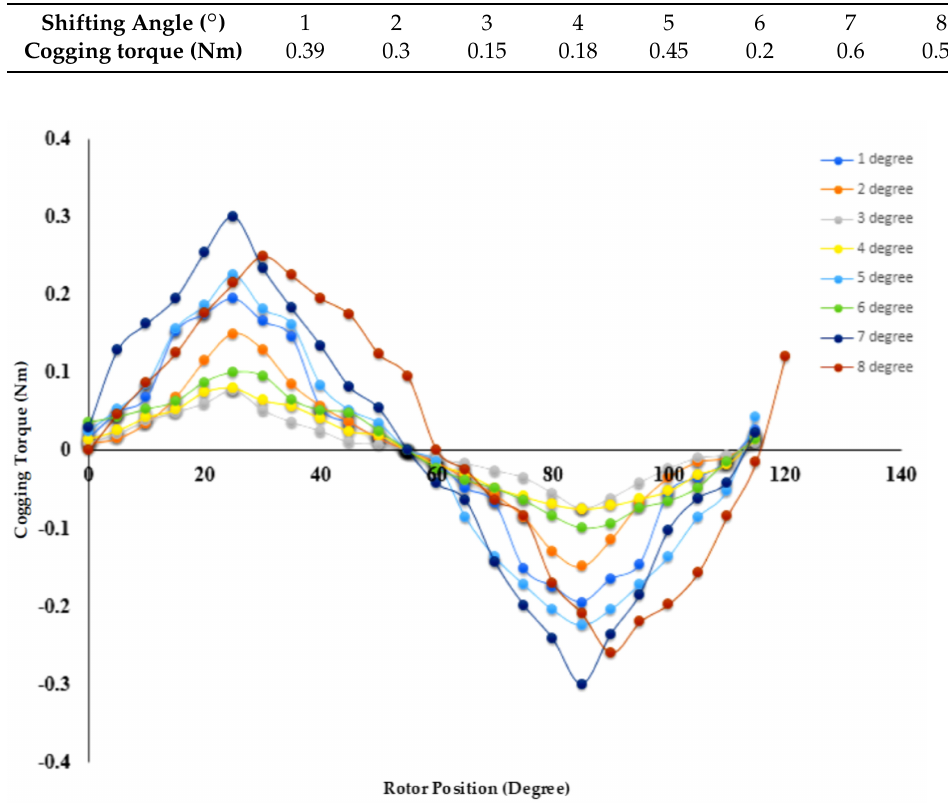
Table 2. Analytical results for cogging torque with shifting angles from 1 ◦ to 8 ◦ .